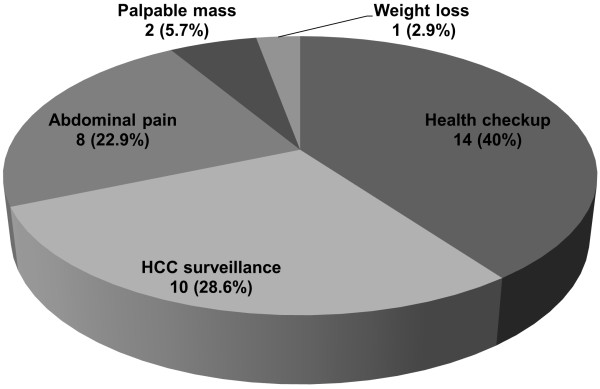
Initial presentation at diagnosis of hepatocellular carcinoma (HCC) in 35 patients with cryptogenic HCC. Of these, only 11 patients presented with symptoms such as abdominal pain, palpable mass, and weight loss.